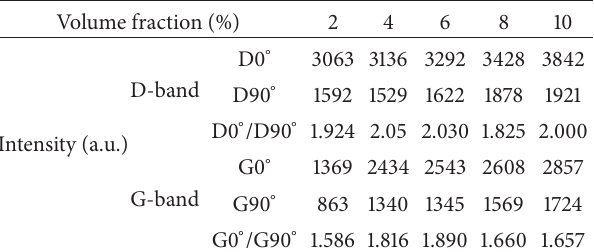
Table 2: Raman spectra intensity and its ratio of oriented MWC- NTs/NR nanocomposite at different MWCNT